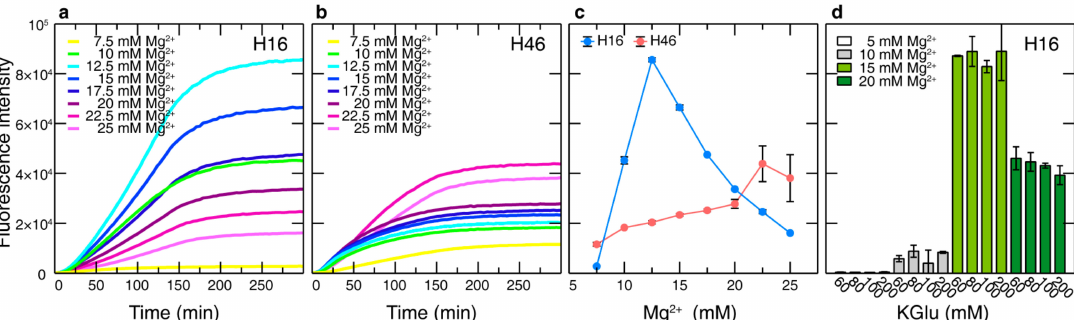
Figure 2. Mg 2 + and K + titrations. The fusion to sfGFP allows the real-time fluorescence readout of the Mg 2 + titration of ( a ) H16 and ( b ) H46. In addition to determining the optimal Mg 2 + concentration, the time-resolved data show when the maximum expression level has been reached. This enables the adjustment of the incubation time of large-scale expressions for each lysate. ( c ) Plot comparing the dependence of H16 and H46 expression on Mg 2 + for a specific lysate. ( d ) Titration of H16 with di ff erent Mg 2 + and K + concentrations. While varying the Mg 2 + concentration strongly a ff ected the expression, it was less sensitive towards variations of the K +